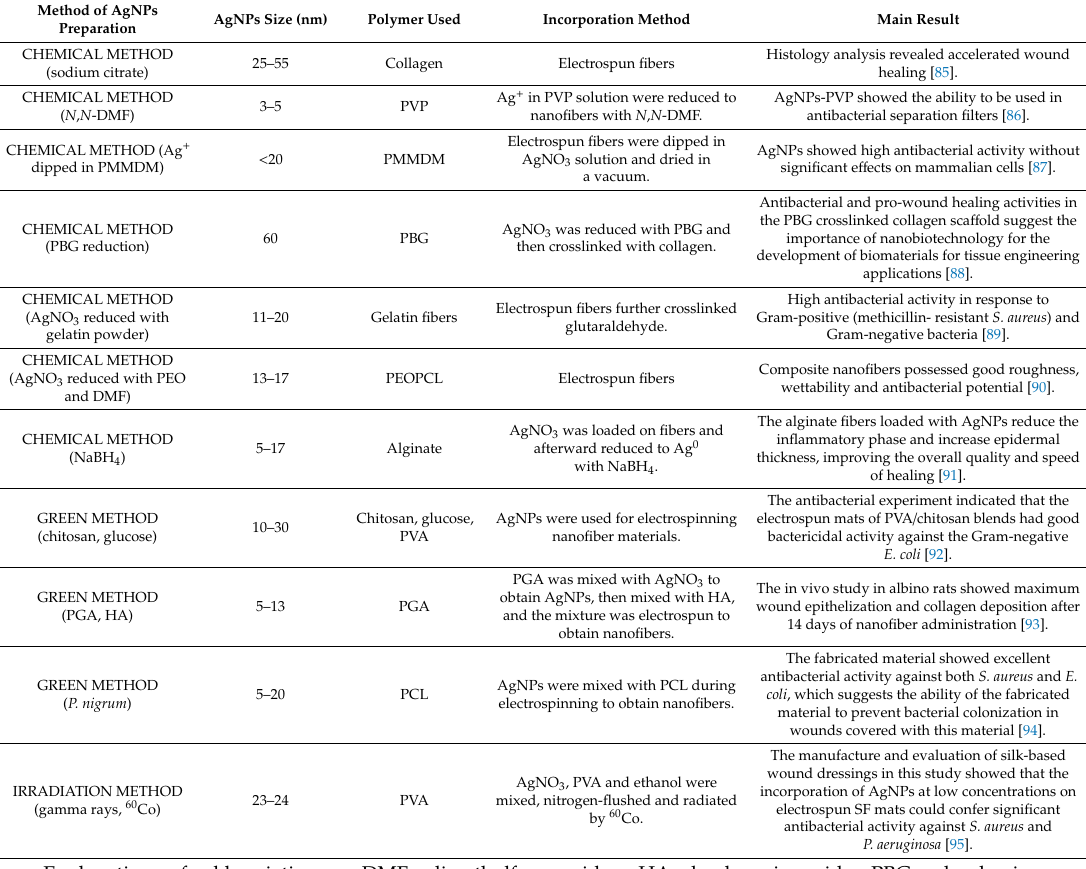
Table 3. AgNPs nanofibers for wound